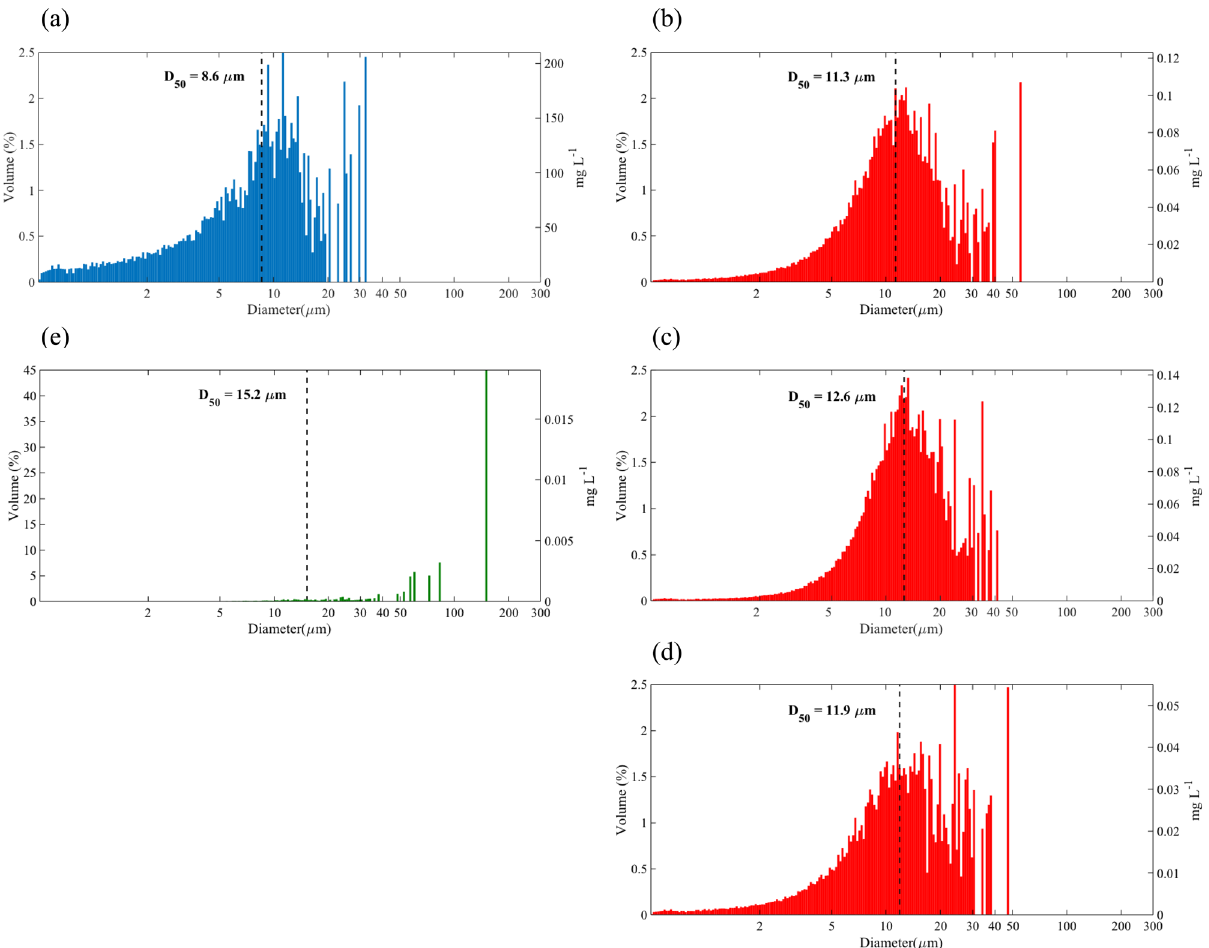
Fig. 6 Laboratory analysis of particle size distribution. Samples were obtained in a the discharge pipe, b – d different sections of the ambient plume 78, 120 and 371 min after the start of the plume release (indicated by the red circles in Figs. 4a, b and 5a, b), and e the background environment at 58 m of depth. The left vertical axis indicates the volume fraction of the distribution (%) and the right vertical axis the mass concentration (mg L − 1 ) for each particle size in the sample. The median particle size is indicated by a black vertical dotted